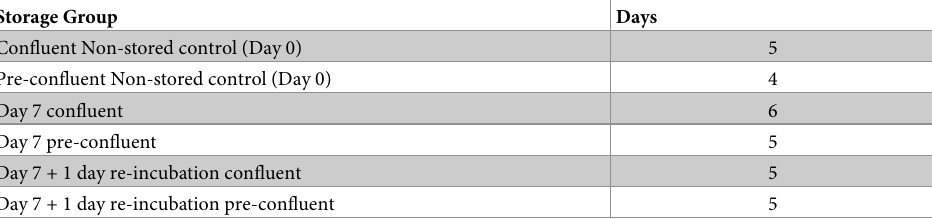
Table 1. Passaged cells: Time to achieve 100%